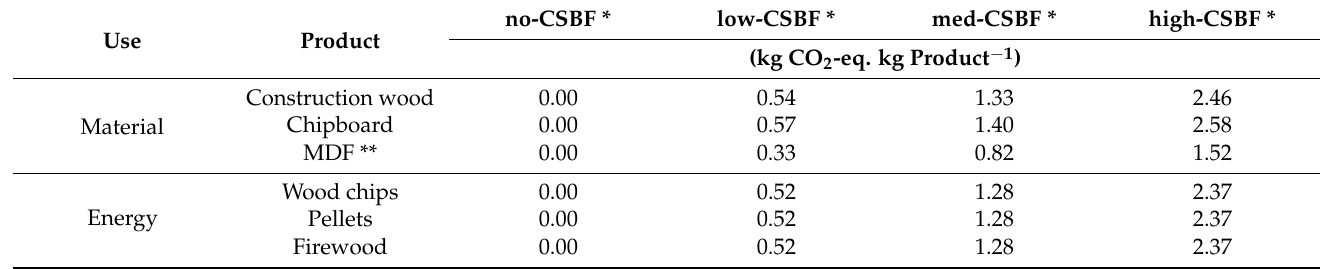
Table 4. Carbon storage balance in forests for individual groups of wood